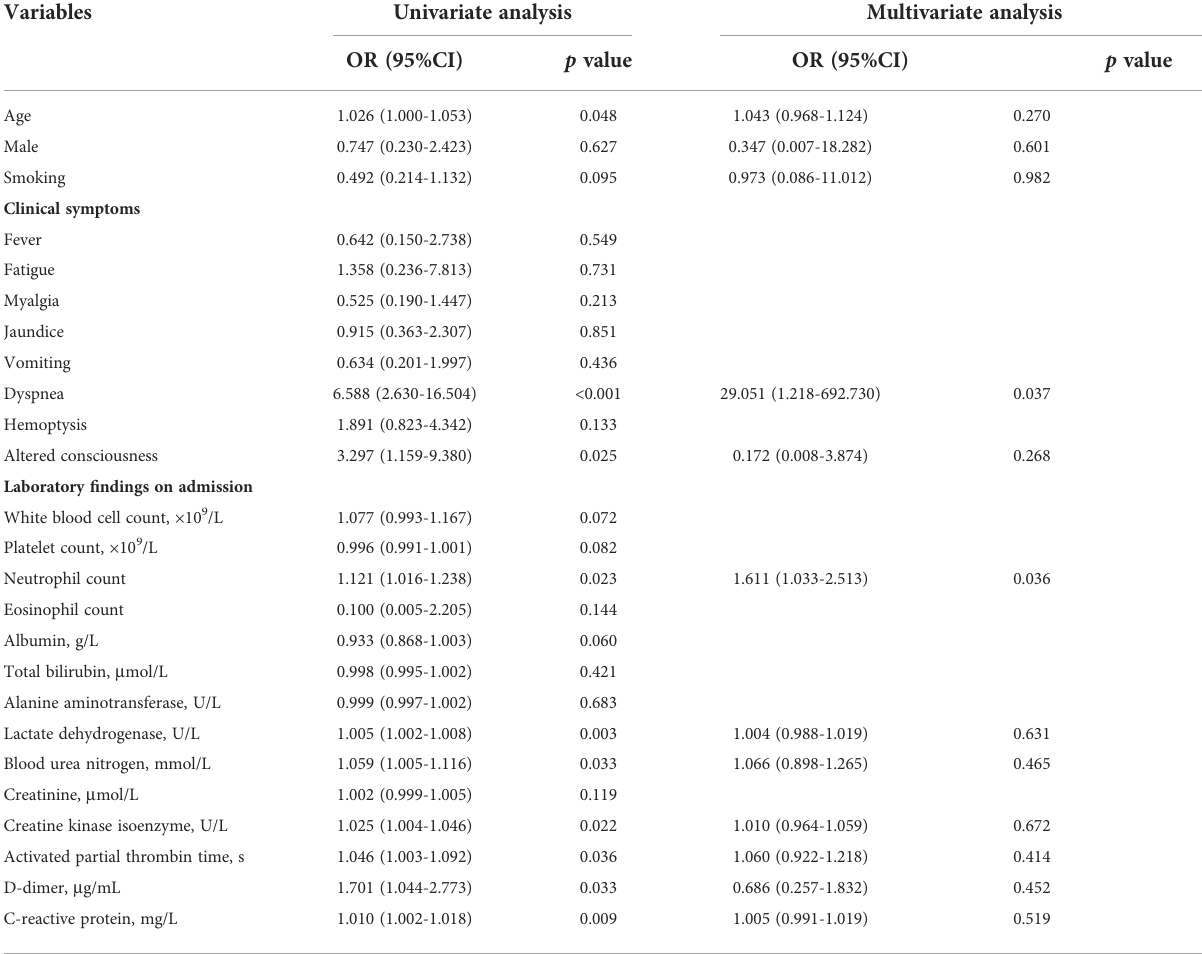
TABLE 4 Logistic regression analysis of risk factors for ICU admission in patients with severe